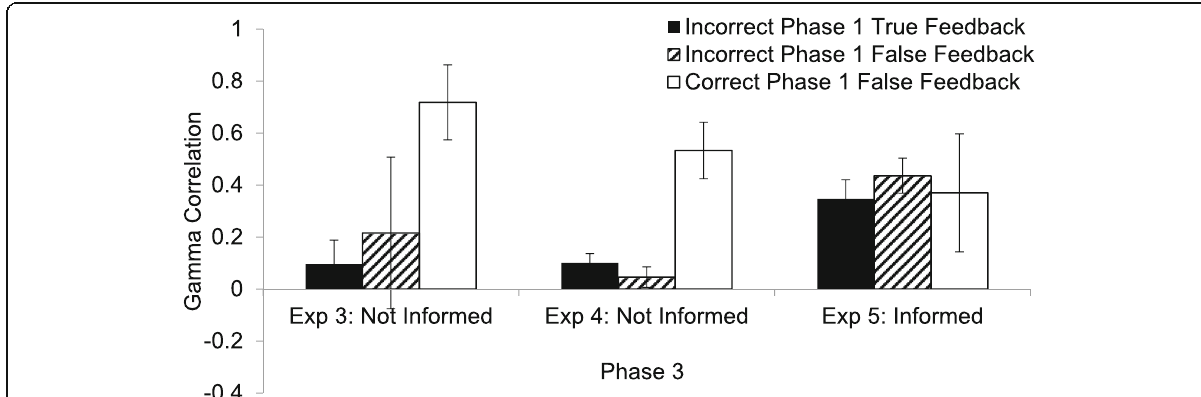
Fig. 4 The γ correlations between confidence in the factual accuracy of responses on the initial, Phase 1 test and correct performance in Phase 3, in which participants were retested and were asked to provide the factually correct answer to each question. The solid black bar represents the standard hypercorrection condition in which the participant answered incorrectly in Phase 1 and was given true feedback. The hatched bar represents the condition in which the participant answered incorrectly in Phase 1 and was given false feedback. The white bar indicates the condition in which the participant answered correctly in Phase 1 and was given false feedback. In the left and center are the results from Experiments 3 and 4, respectively, in which participants were not informed about whether the to-be-learned word, provided as feedback, was true or false. On the right are the results from Experiment 5 in which participants were informed, immediately upon being presented with the to-be-learned word in red, whether that feedback was true or false, and, if false, what the true answer was. Error bars indicate the standard error of the